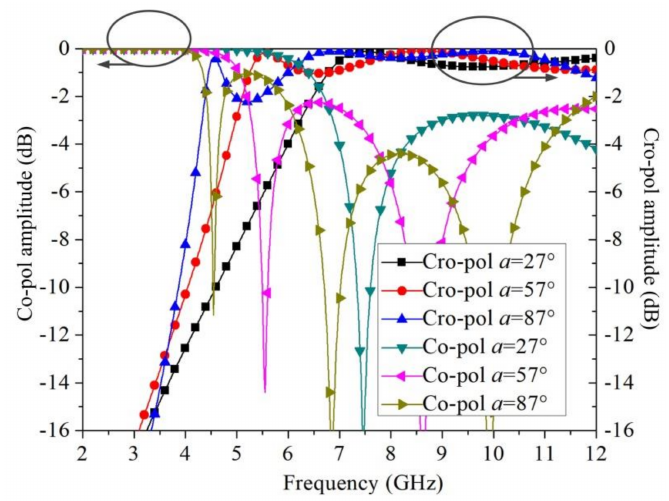
Figure 6. Simulated reflection amplitudes of a reflect surface unit cell with co-polarization and cross-polarization.